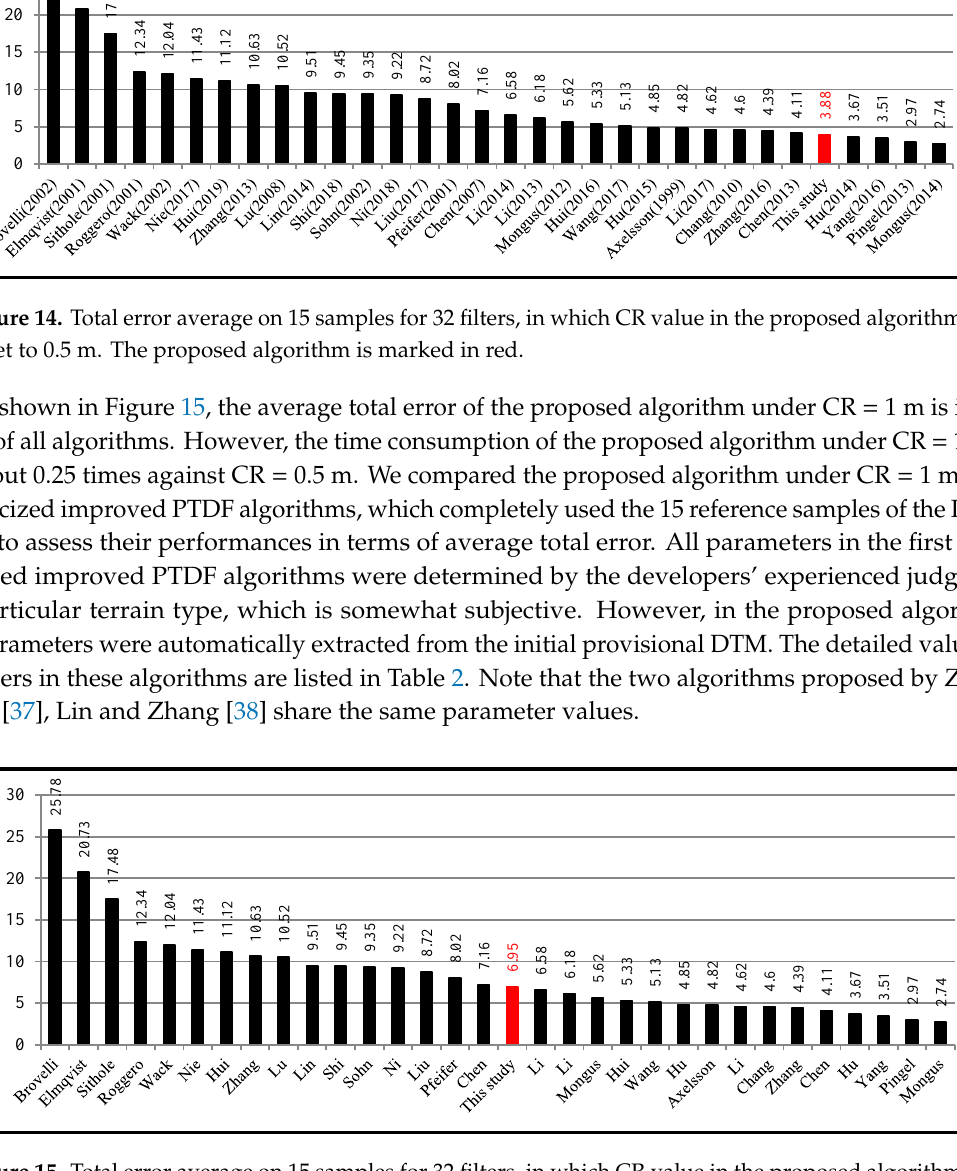
Figure 15. Total error average on 15 samples for 32 filters, in which CR value in the proposed algorithm is set to 1 m. The proposed algorithm is marked in red.